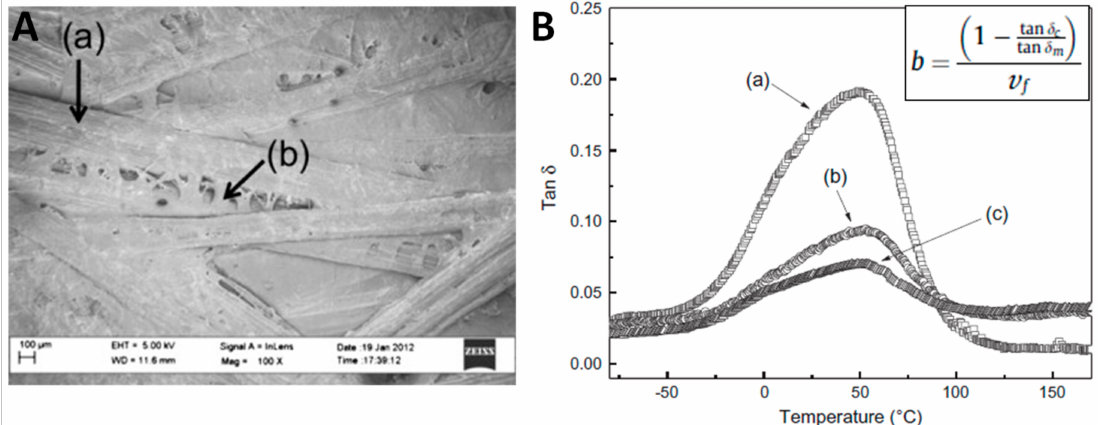
Figure 20. ( A ) SEM micrograph of sisal fibre with ( a ) preform using ( b ) BC as binder; ( B ) results of DMTA tests with tan δ as a function of temperature for ( a ) neat polyAESAO, ( b ) sisal-polyAESO and ( c ) BC-sisal-polyAESO biocomposites (reprinted with permission from Lee et al. (2012)